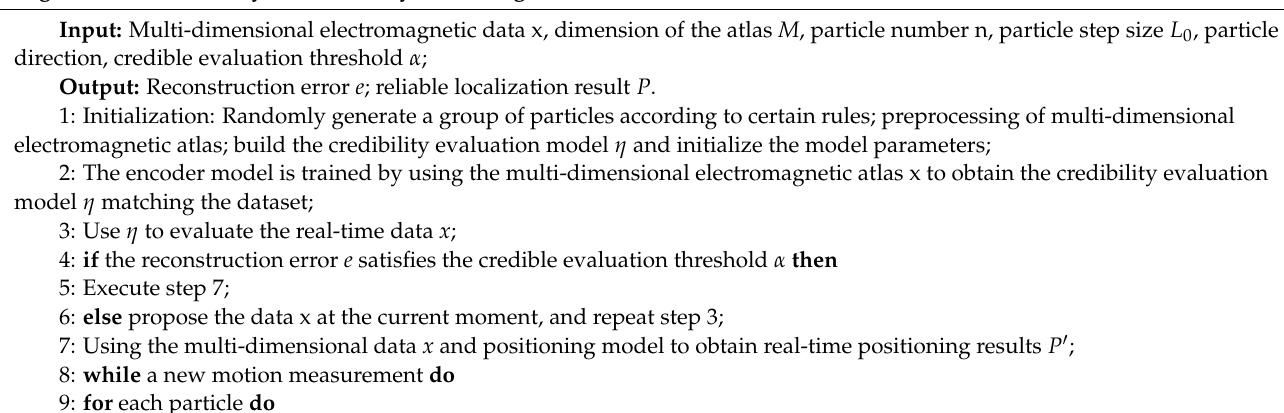
Algorithm 2: Credibility Evaluation System